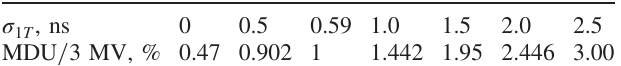
TABLE V. Flatness of the top of the output pulse of the LTD module consisting of 30 cavities connected in series depending on the switch jitter.